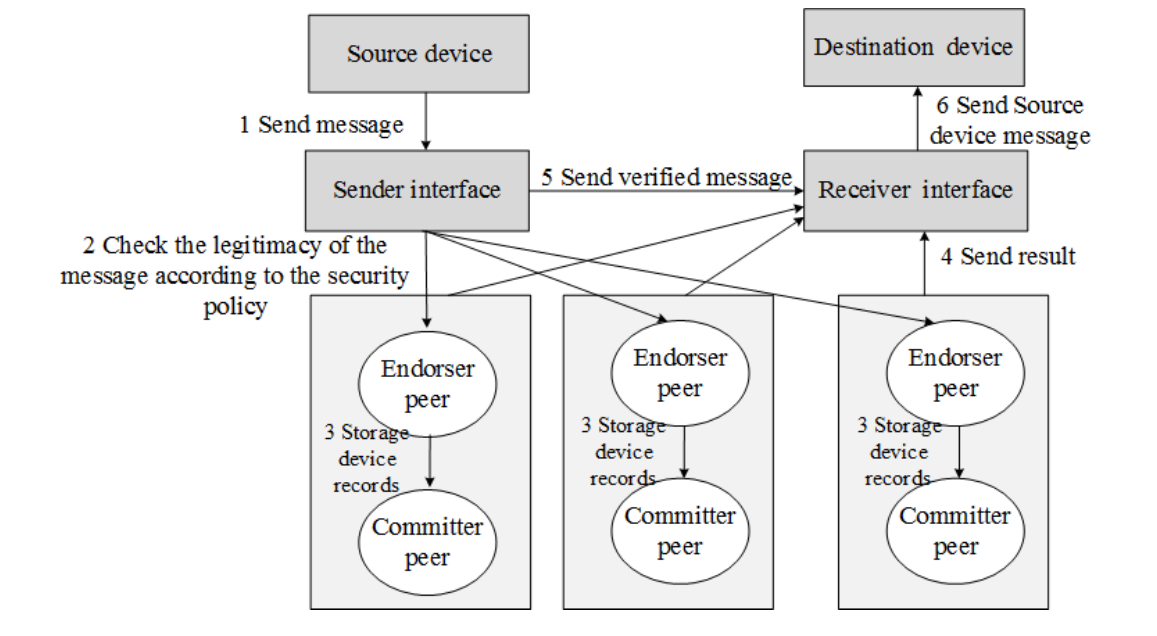
Figure 5. Reconstruction diagram of reference [26].